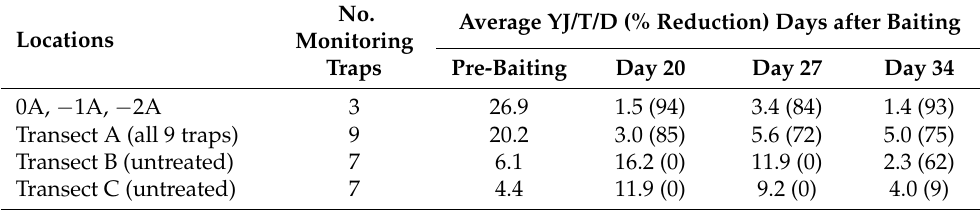
Table 1. The average number of yellowjackets trapped per trap per day (YJ/T/D) and